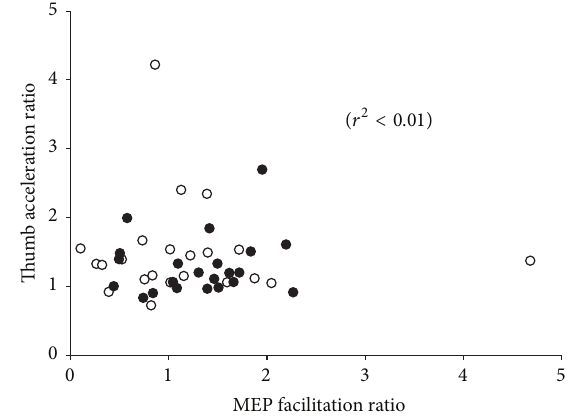
Figure 4: Relationship between motor performance improvement and cortical excitability changes following MT. Linear regression analysis revealed a nonsignificant relationship ( 𝑟 2 < 0.01) between acceleration ratio (max. acceleration post-MT/max. acceleration pre-MT) and MEP facilitation ratio (MEP amplitude post-MT/MEP amplitude pre-MT). Data include morning (unfilled circles) and evening (filled circles) experiments.